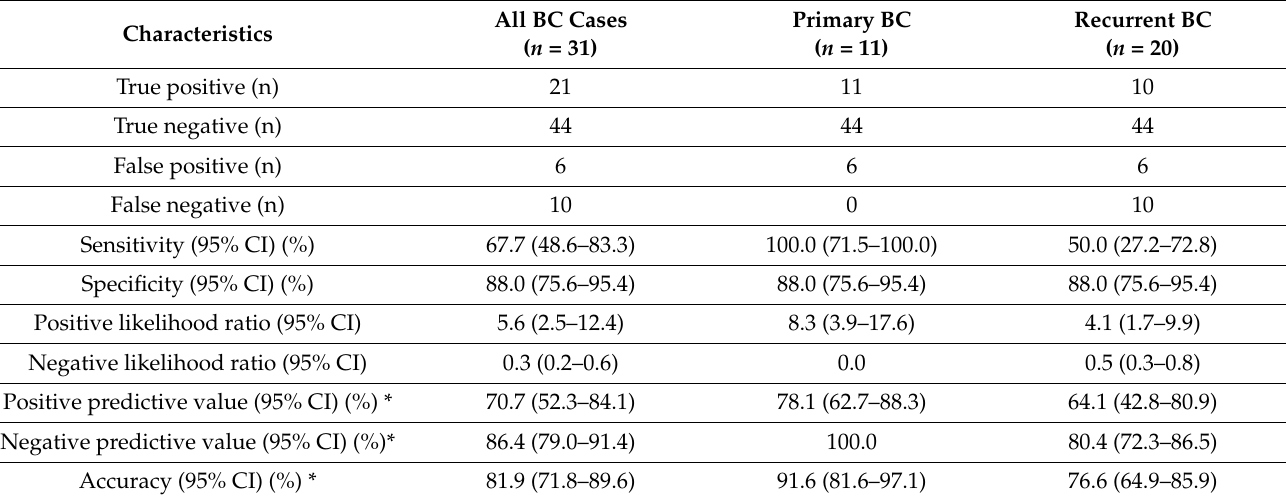
Table 2. Performance of uTERTpm in detecting primary and recurrent bladder